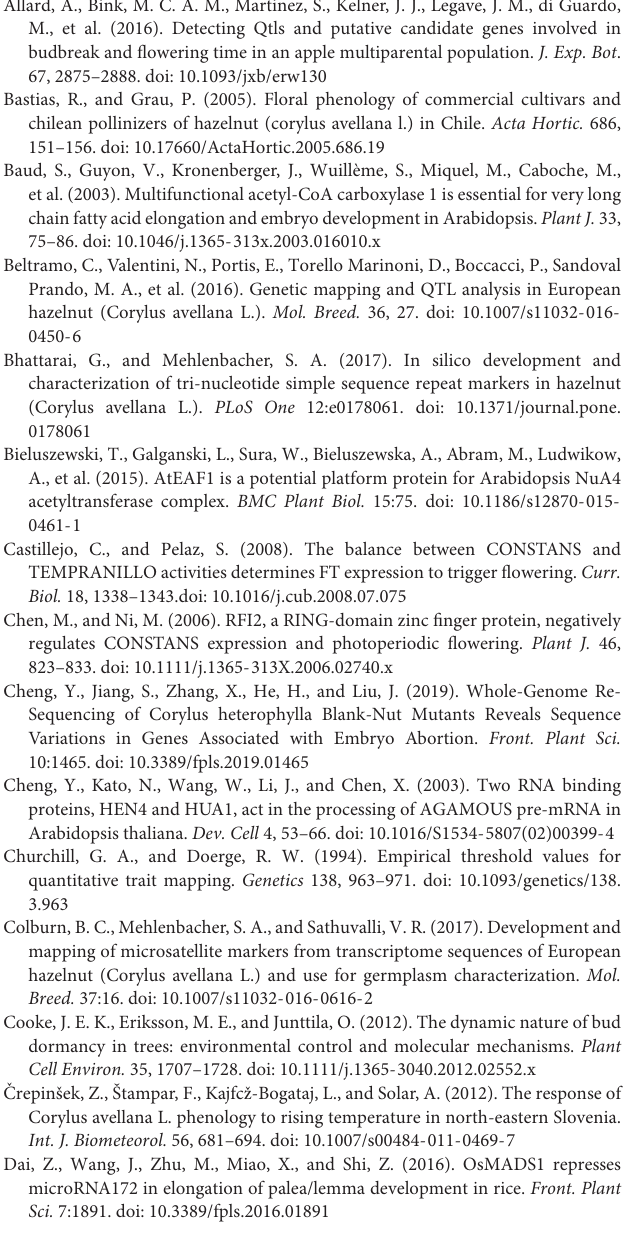
Supplementary Figure 1 | Candidate genes underlying variation in phenology in hazelnut. (A) A four-way Venn diagram illustrating overlap in the genes mapping within the regions harboring tmf , tff , dc , and tnm QTL. (B) Functional categorization of the 121 genes potentially underlying variation in tmf , tff , dc , and